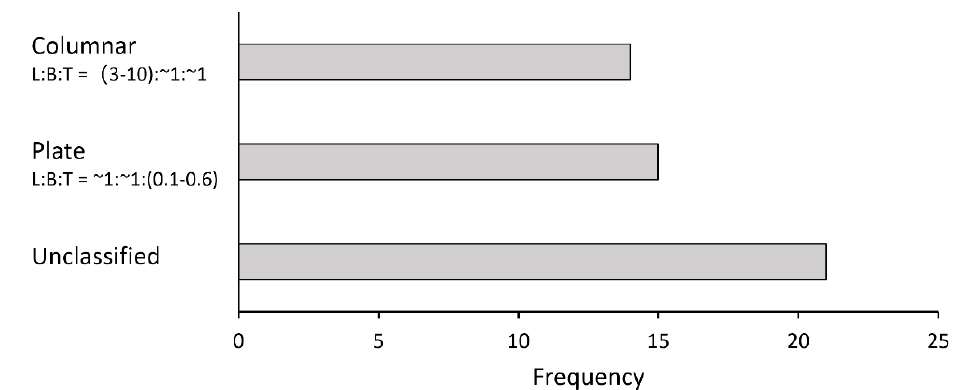
Figure 6. Shape descriptions of the selected 50 particles based on their length, breadth, and thickness (L:B:T) ratios.